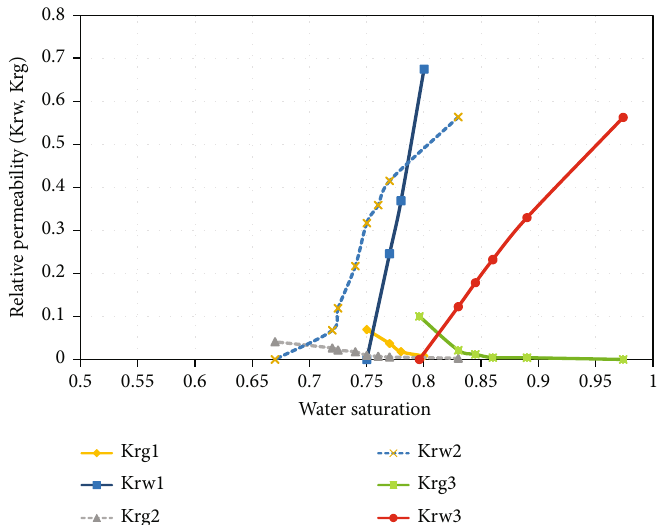
Figure 3: Relative permeability curve of di ff erent samples.